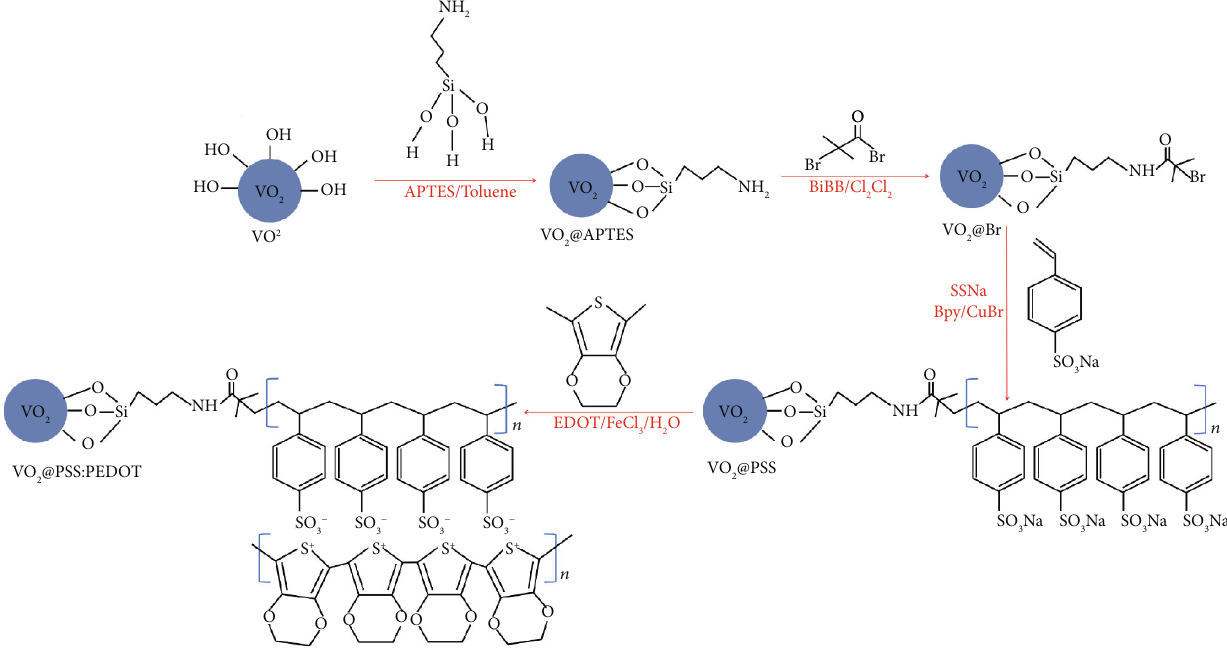
particles with PEDOT: PSS chains. 2